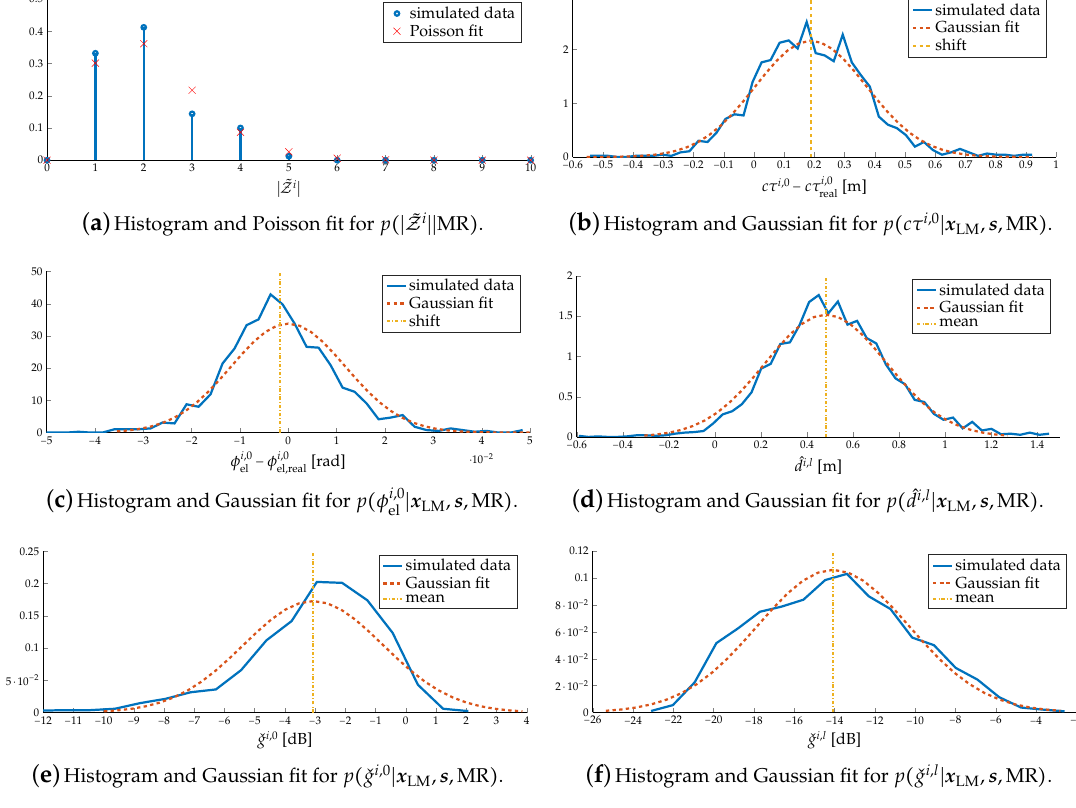
Figure 8. Some components of the likelihood for